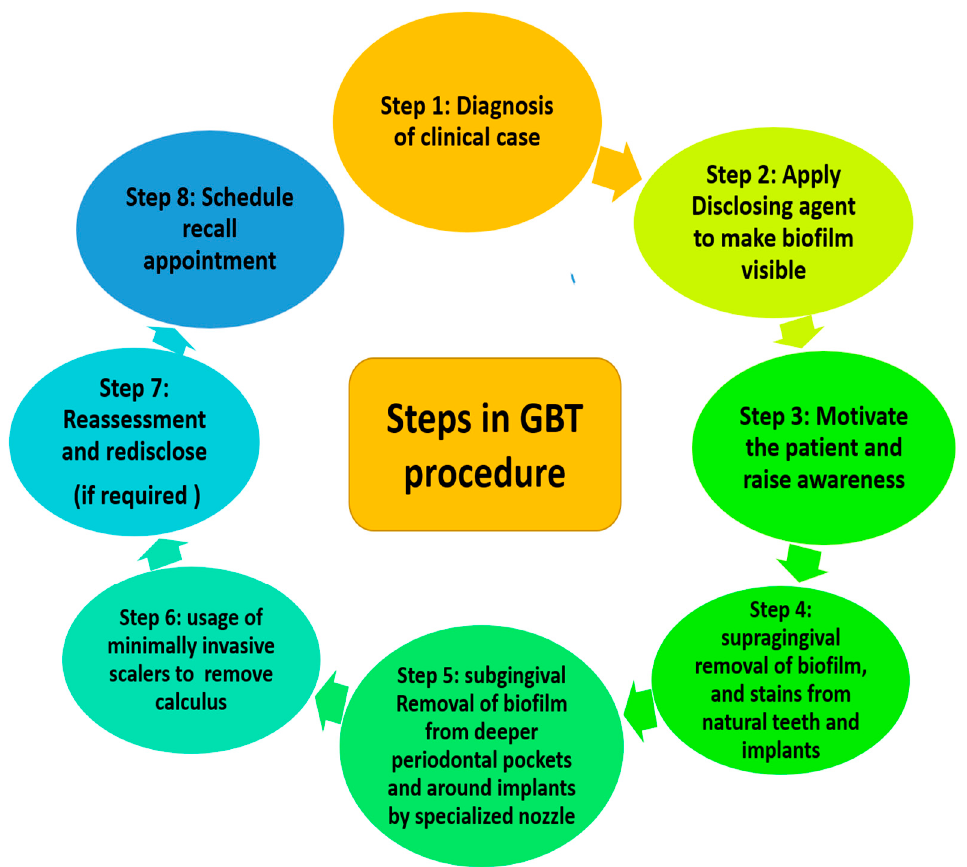
Figure 1. Steps in guided biofilm therapy (GBT).